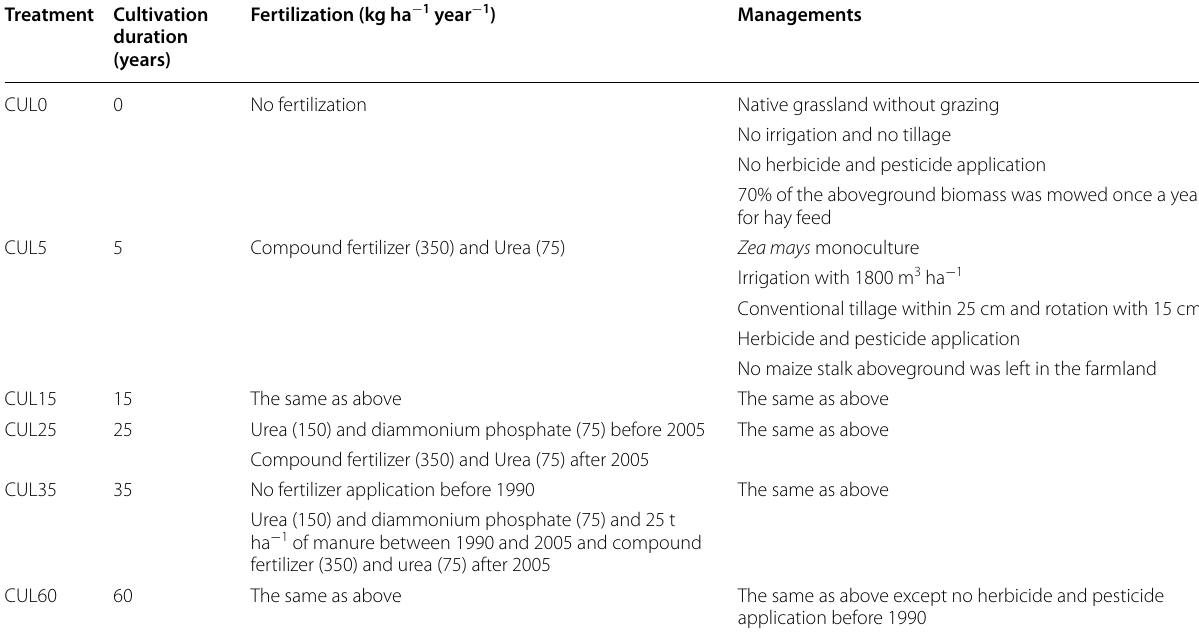
Table 1 Management history of native grassland and cropland plots of different periods of continuous cultivation in Horqin Sandy